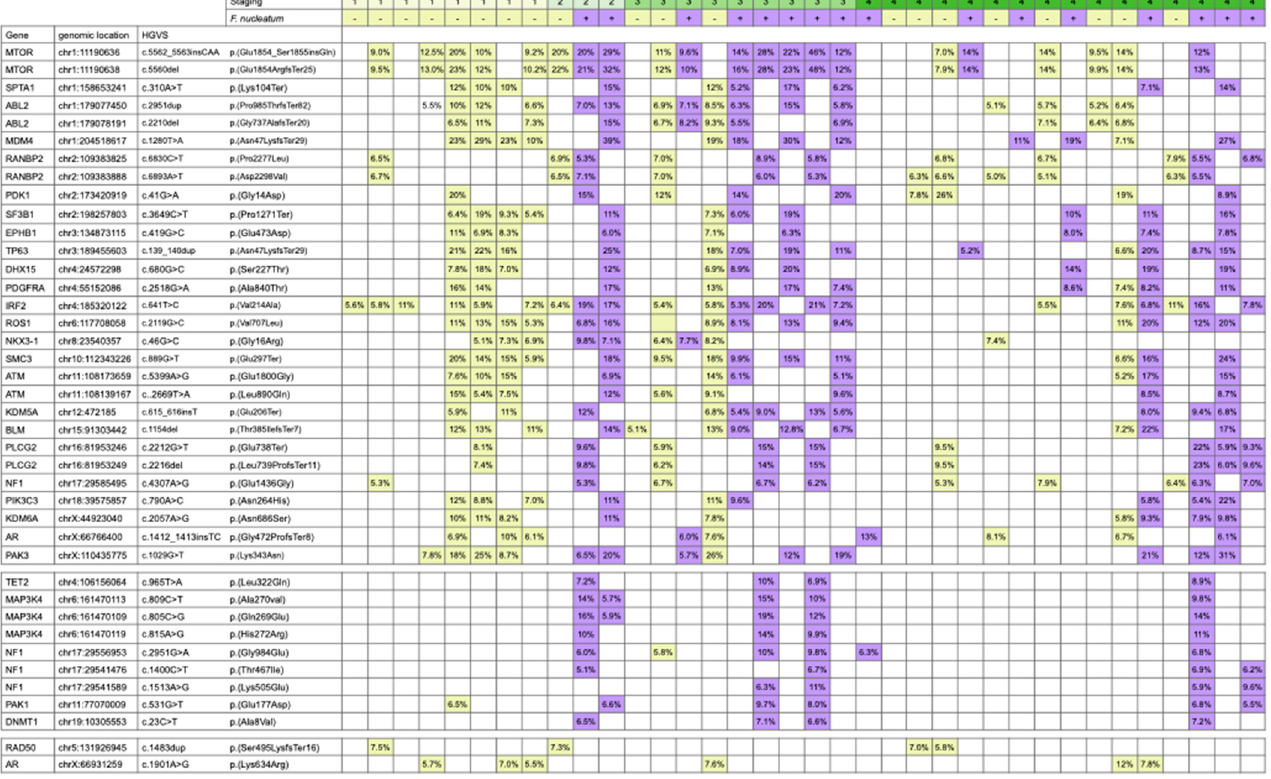
Figure 3. The variants in the SNV/INDEL identified in the specimens share common features.